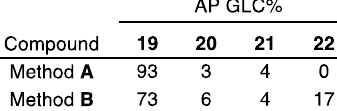
Scheme 7. Pd-catalyzed dehydrogenative alkenylation of 1-methyl-1 H -imidazole ( 18 ) with styrene ( 2a ) according to